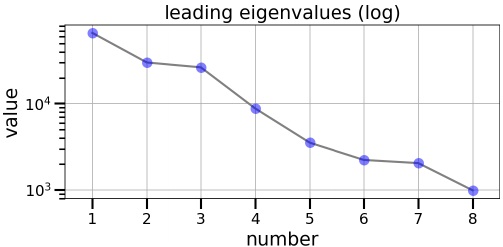
Figure 7. Leading eigenvalues of biogenic emissions for indepen- dent sensitivities including additional uncertainties. Plotting con- ventions are the same as in Fig.